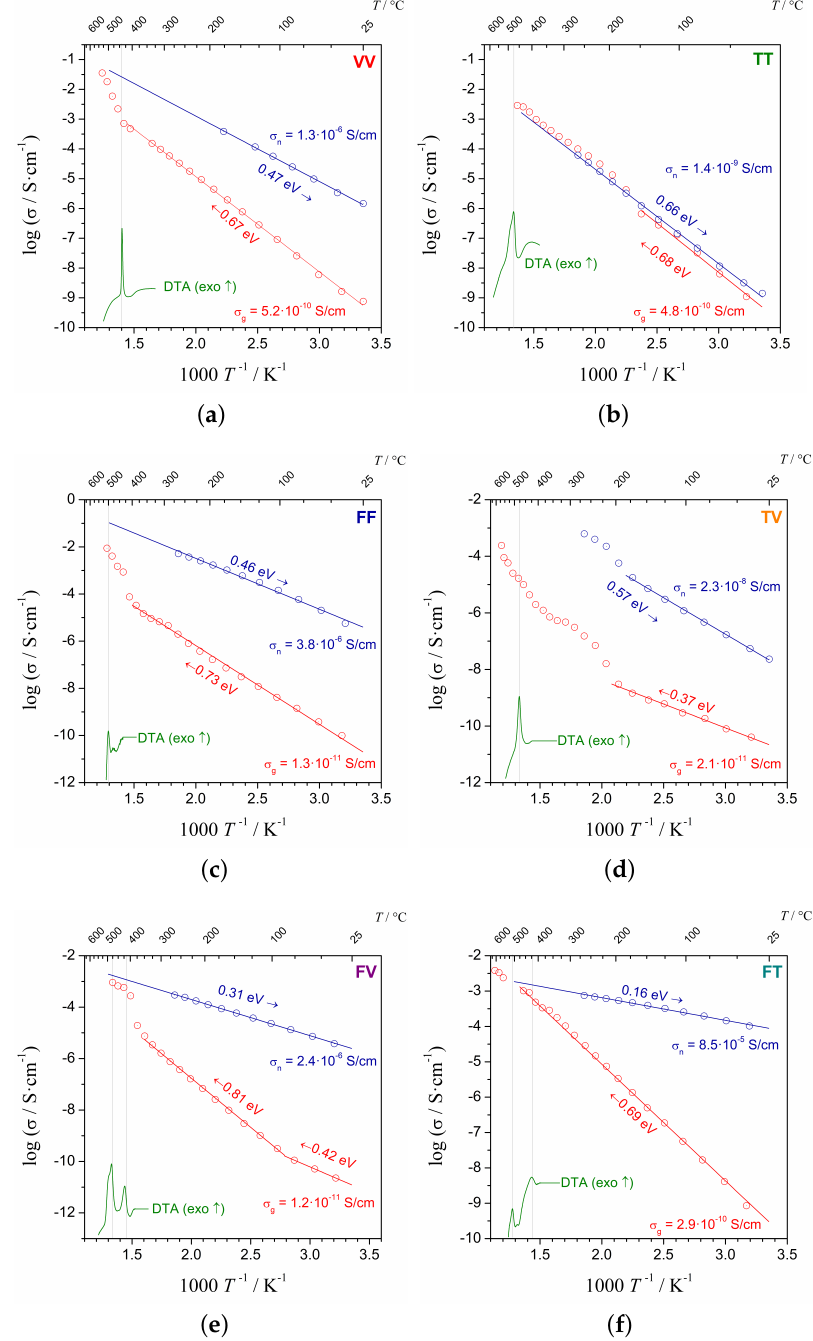
Figure 4. Temperature dependencies of electrical conductivity upon heating of glassy samples (red circles) and samples nanocrystallized at optimum temperature (blue circles). The activation energies are given along with the value of the room temperature conductivities. DTA traces measured at 1 ◦ C/min are provided for comparison: ( a ) VV; ( b ) TT; ( c ) FF; ( d ) TV; ( e ) FV; ( f )